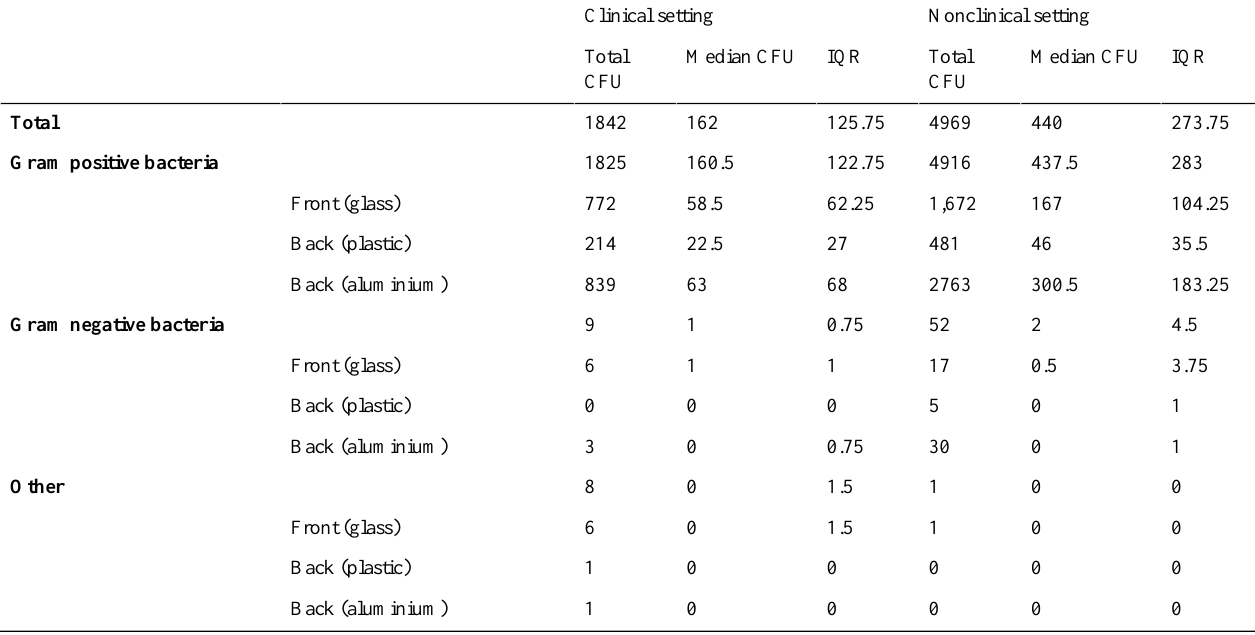
Table 1. Recovery of pathogens found on the devices’surfaces on initial arrival at the laboratory (shown as cumulative number of CFU from 10 tablet PCs each). Comparison of the total number of microorganisms: Mann-Whitney U test, z=- 3.402; P=.